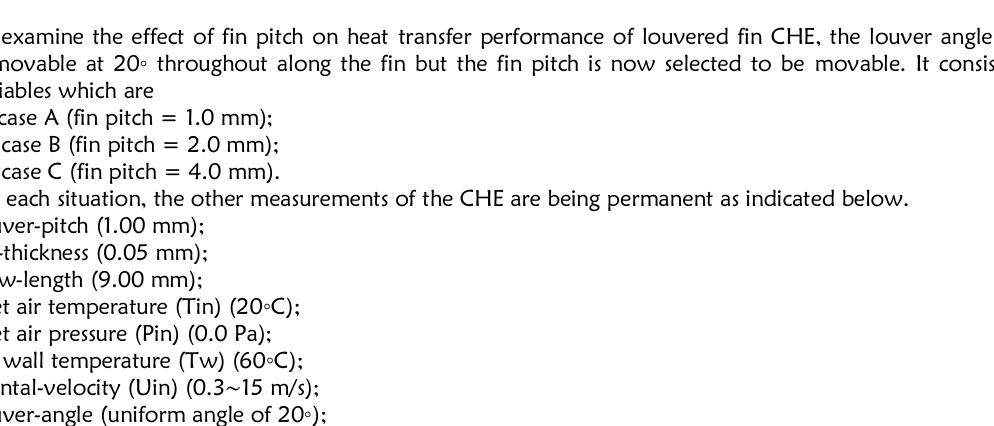
Figure 18: Five altered cases of consecutively improved and reduced louver angle (+2 ◦ , +4 ◦ , −2 ◦ , −4 ◦ , and uniform angle 20 ◦ )